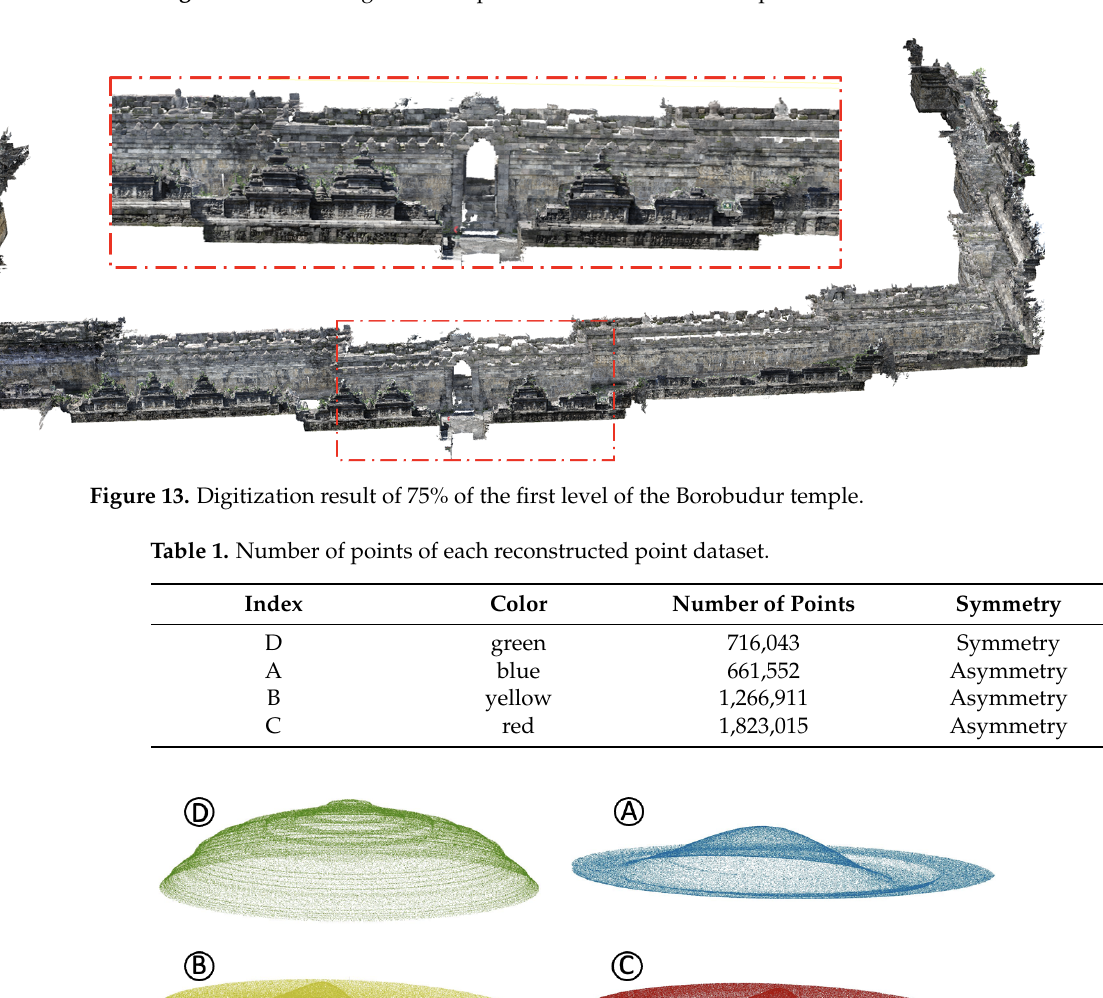
Figure 12. Close-range scanned points of the Borobudur temple.